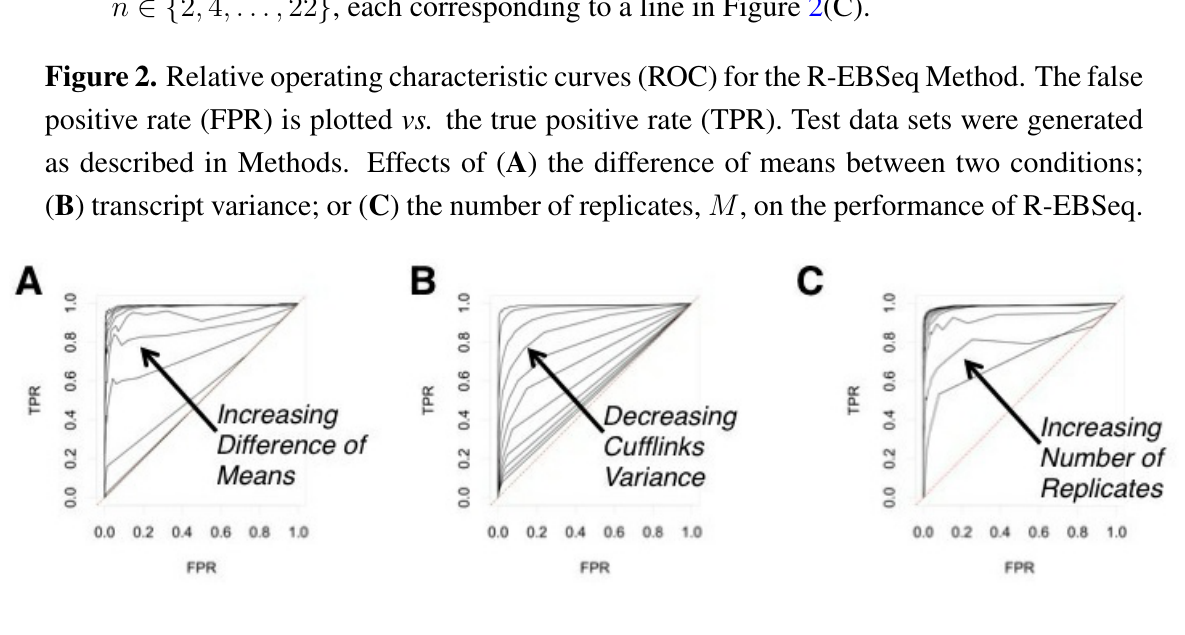
Figure 2. Relative operating characteristic curves (ROC) for the R-EBSeq Method. The false